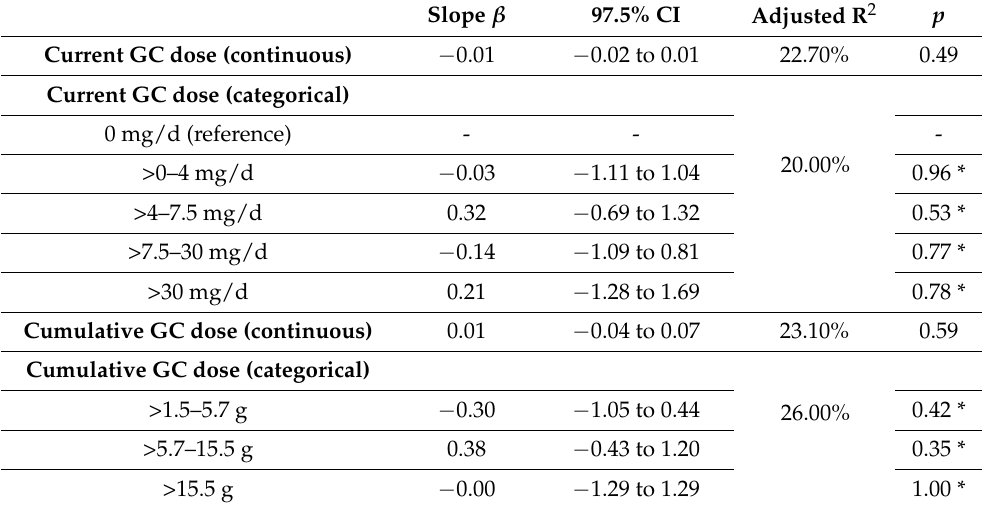
Table 4. Results of adjusted multiple linear regression analyses with minimum T-score as the depen- dent variable and current and cumulative glucocorticoid (GC) intake as continuous or categorical predictors.